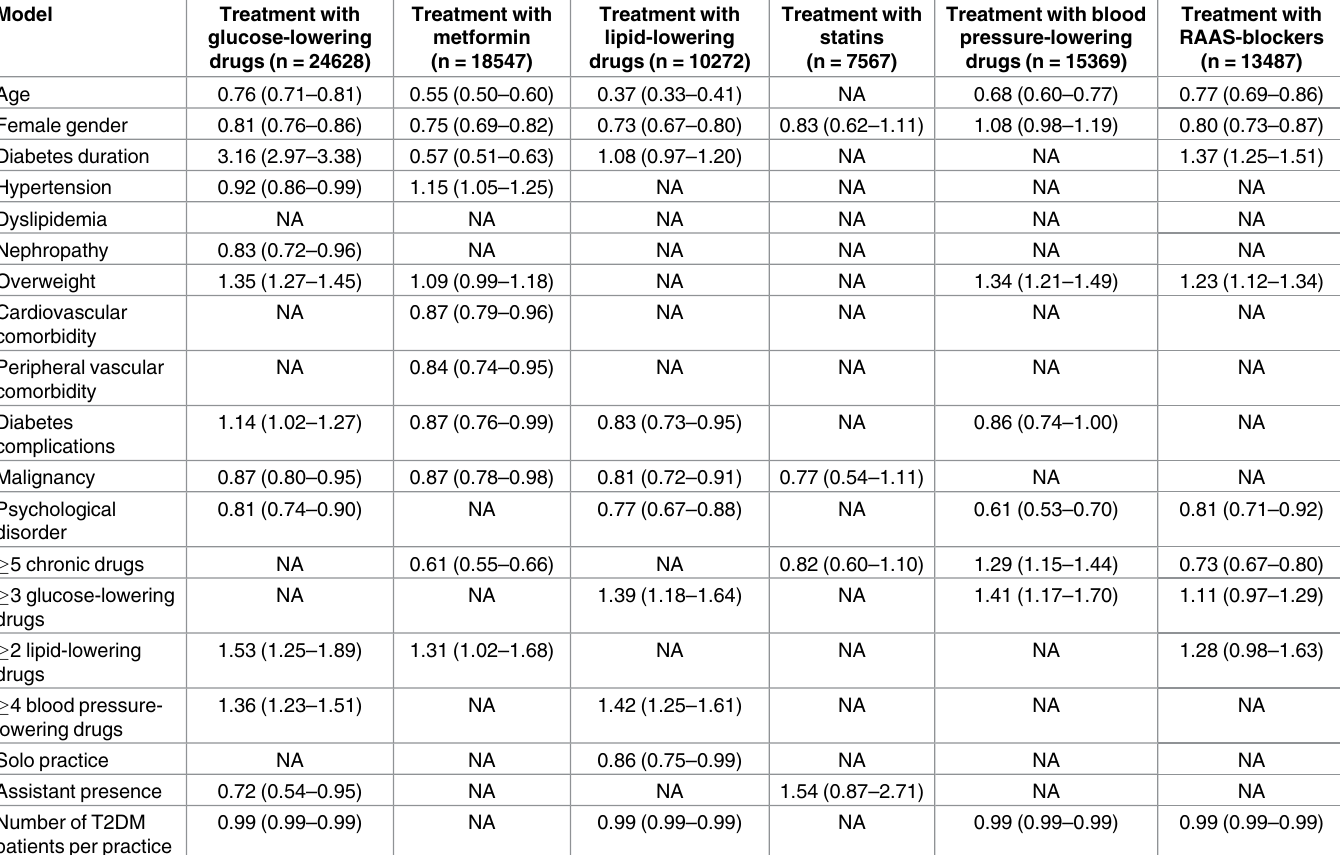
Table 4. Effect sizes of the association between the characteristics and treatment outcomes as described in model 3 in the methods (all the selected variables are included into the models).